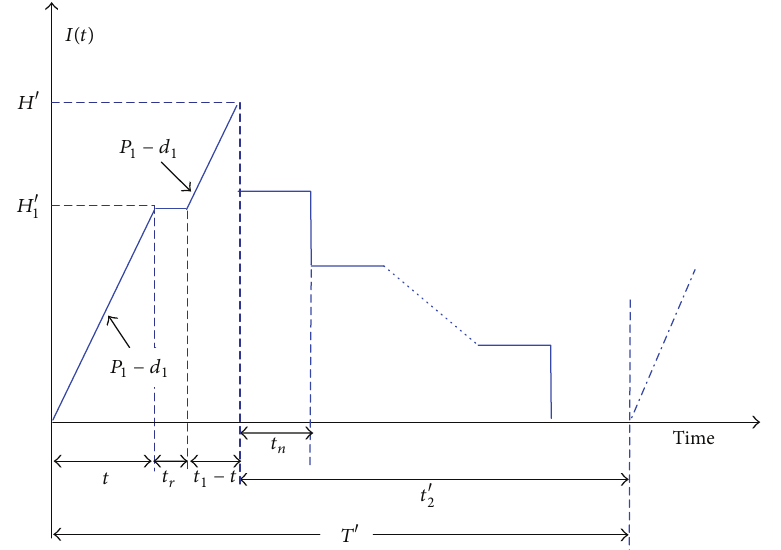
Figure 1: Inventory level of finished items in the proposed manufacturing run time